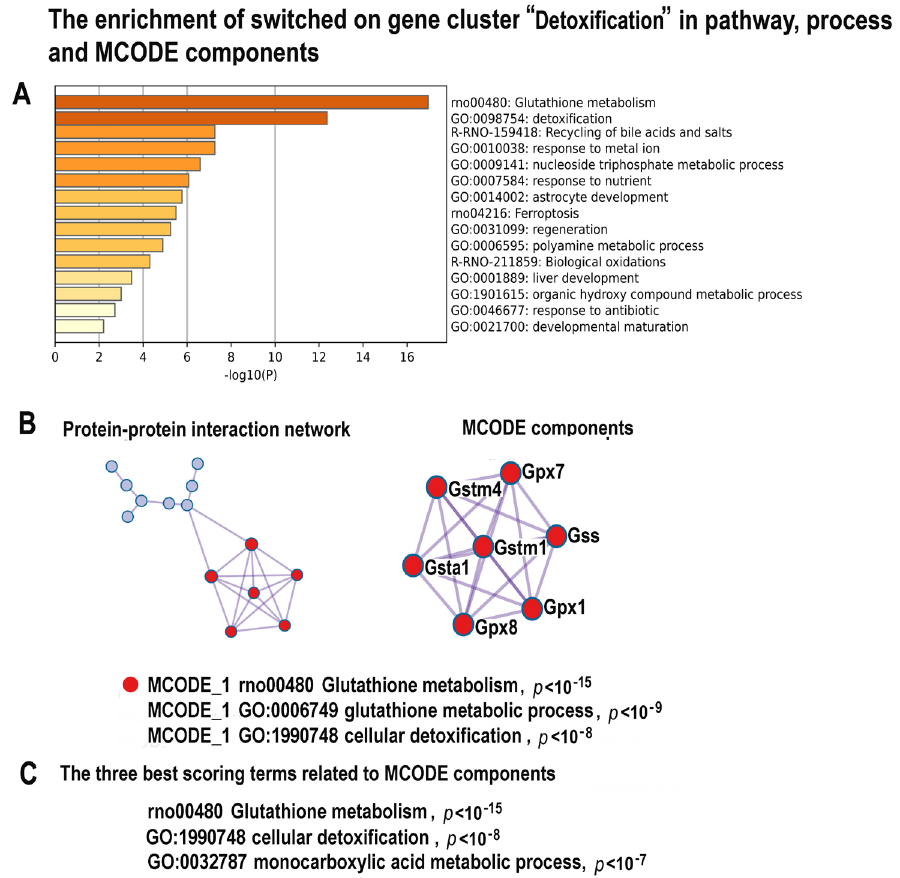
Figure 11. The enrichment of NLI − inhibited genes related to the cluster “Detoxication” in gene pathway and process and molecular complexes. ( A )—Bar graph of enriched terms related to gene pathways and processes across the gene cluster related to detoxification, colored by different p -values. ( B )—Protein–protein interaction network and MCODE components (or densely connected network components) were identified in the gene list. The network and MCODE components were constructed on the base of physical interactions taken from String server (physical score > 0.4). The coding by color square reflects the MCODE components. The coding by color circles indicates the results of MCODE component pathway and process enrichment analysis. ( C )—The three best-scoring terms related to MCODE components.